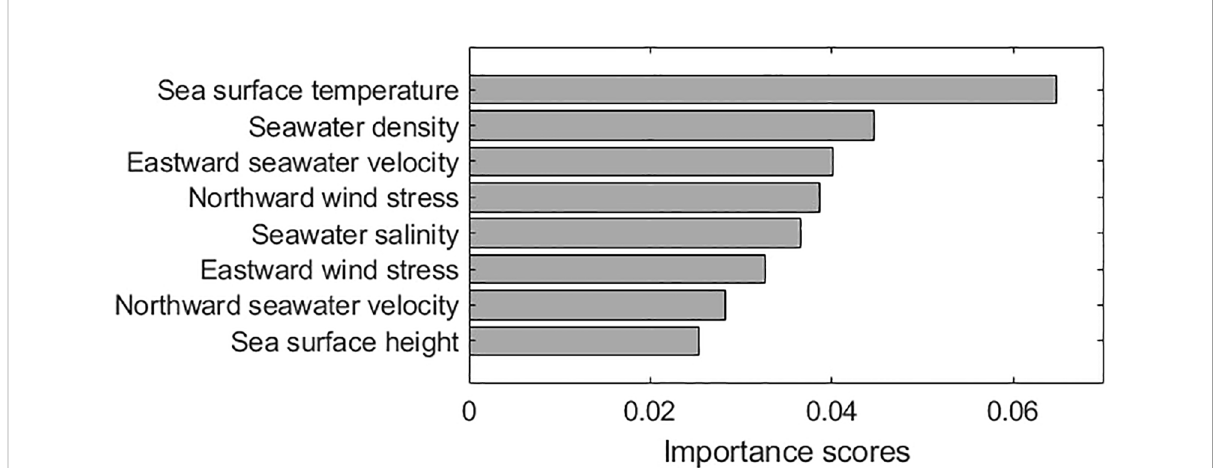
FIGURE 2 The rank of features in minimum redundancy maximum relevance (mRMR) algorithm for identifying the importance between environmental variables affecting Sargassum distribution. Environmental variables include sea surface temperature (SST), seawater density ( rho ), seawater salinity (SS), sea surface height (SSH), eastward seawater velocity ( uo ), and northward seawater velocity ( vo ), eastward wind stress ( wsu ), and northward wind stress ( wsv